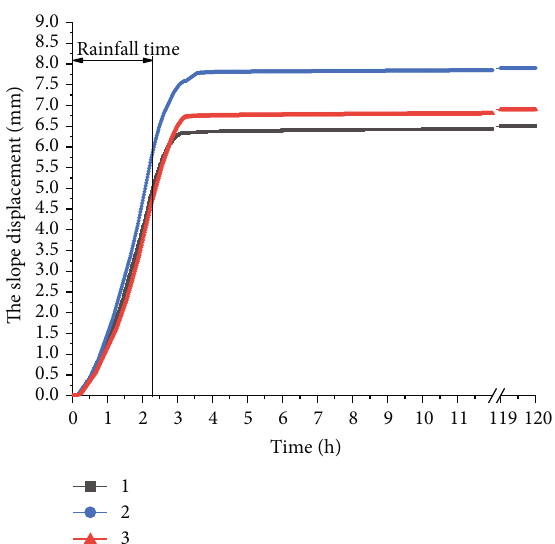
Figure 20: The changes of the lower slope water content with time.